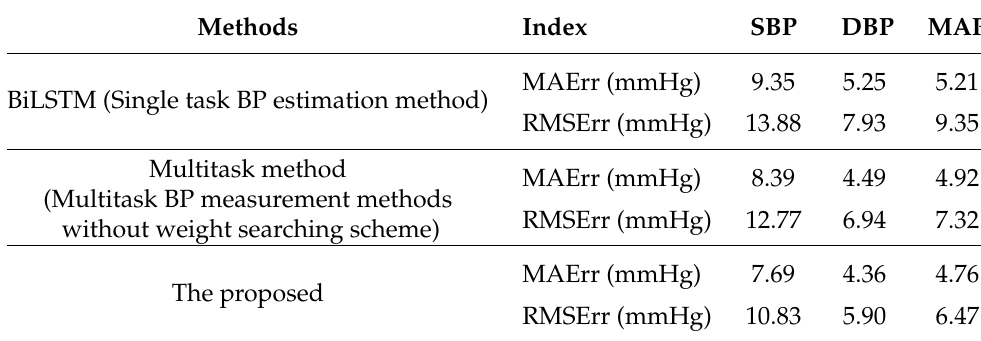
Table 3. BP Estimation Performance for the Proposed Method with Different Neural Network Architectures and Searching Scheme of Task-specific